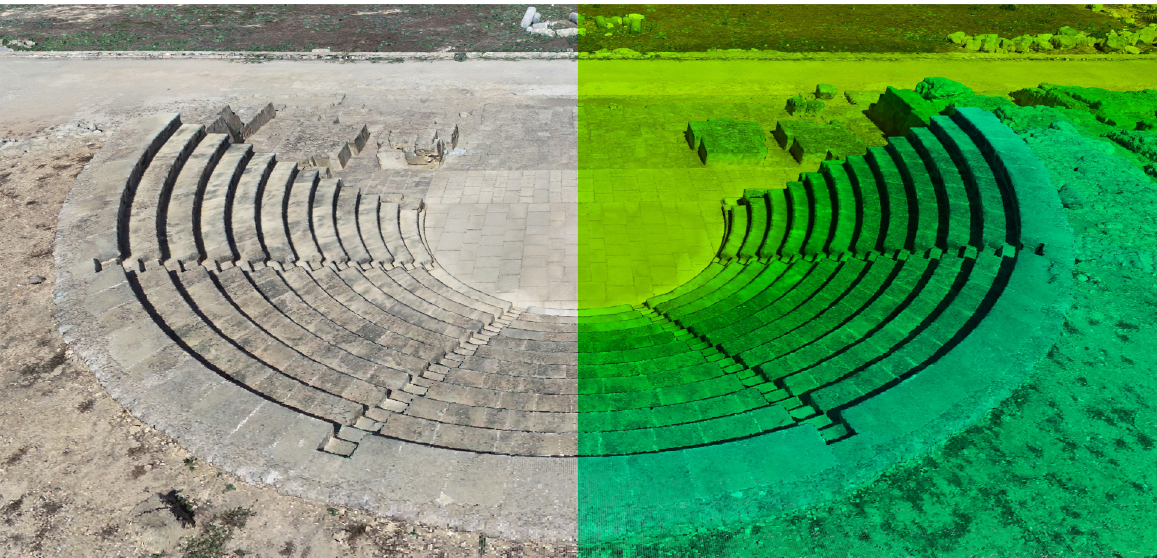
Fig. 7 3D photogrammetric mesh of the Nea Paphos Archeological Site (2019) (Source: the